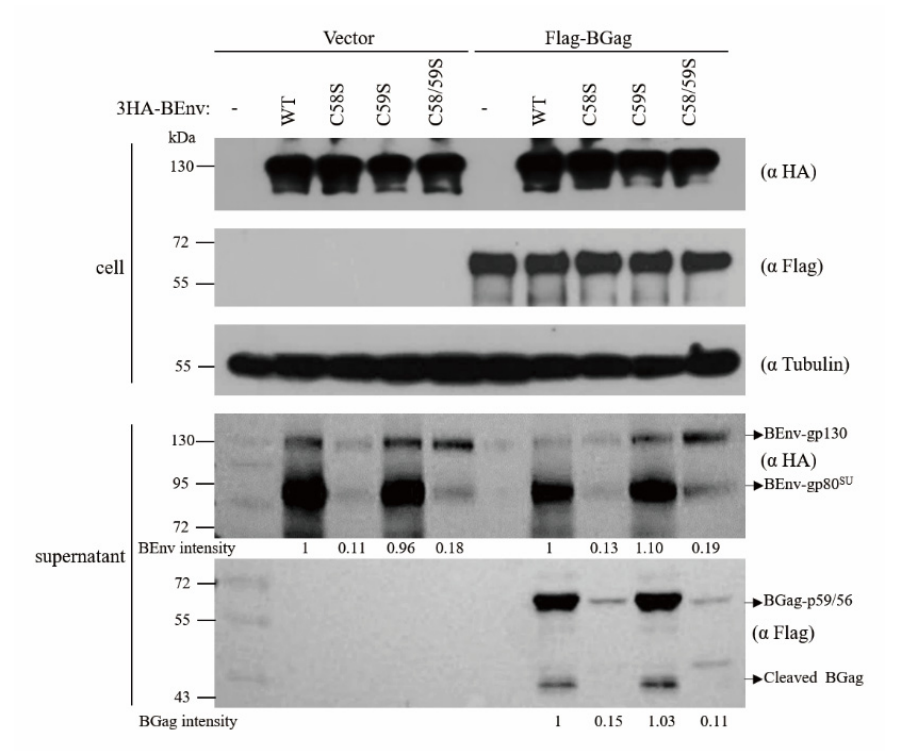
Figure 4. BEnv palmitoylation is critical for BFV SVP release. HEK293T cells were transfected with either wild type or mutant 3HA-BEnv and Flag-BGag as indicated. After 48 h, cells were lyzed and subviral particles were harvested by ultracentrifugation through a 20% sucrose ( w / v ) cushion from cell culture supernatants as described in the Materials and methods. BEnv and BGag in cell lysates and viral particles were detected by Western blotting using the indicated antibodies. The indicated band intensities were quantified with Image J.